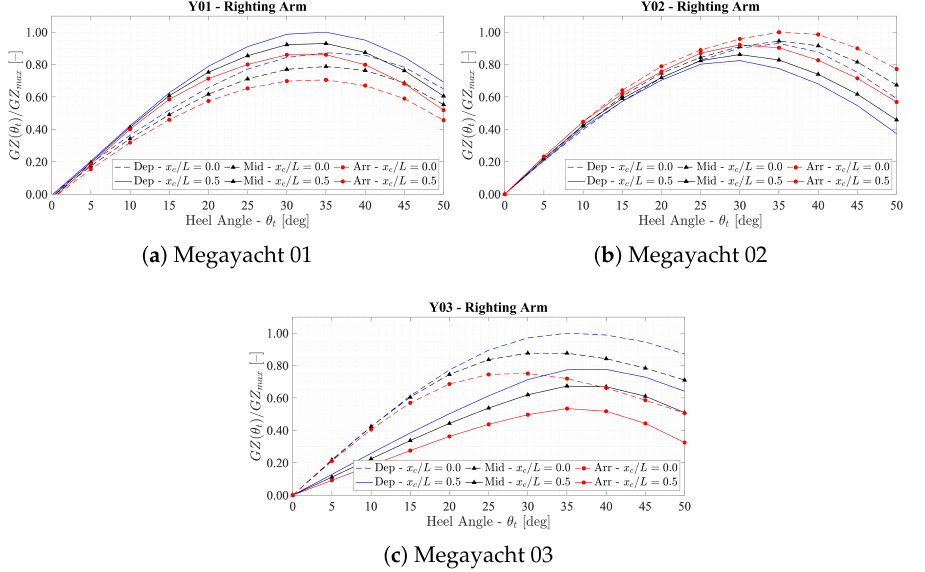
Figure 2. Diagram of the righting arm in waves for each unit. The wave crest amidship conditions are represented by continuous lines while the wave trough amidship conditions are represented by dashed lines. The wave steepness, S w , is equal to 0.0334 and the wavelength equal to the ship.